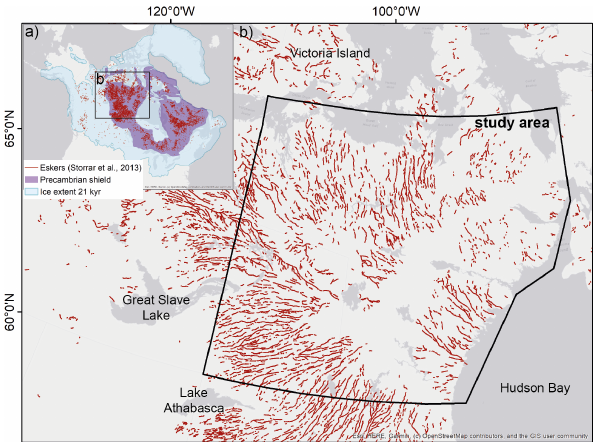
Figure 3. (a) Large-scale distribution of eskers around Hudson Bay (Storrar et al., 2013). The Laurentide Ice Sheet extent displayed in the inset is the Last Glacial Maximum (LGM) at 18ka ( 14 C; 21.4kacalBP) (Dyke et al., 2003) and the extent of the Precam- brian shield is also mapped (Wheeler et al., 1996). (b) Zoomed-in location of the study area focussed on the area around the former Keewatin Ice